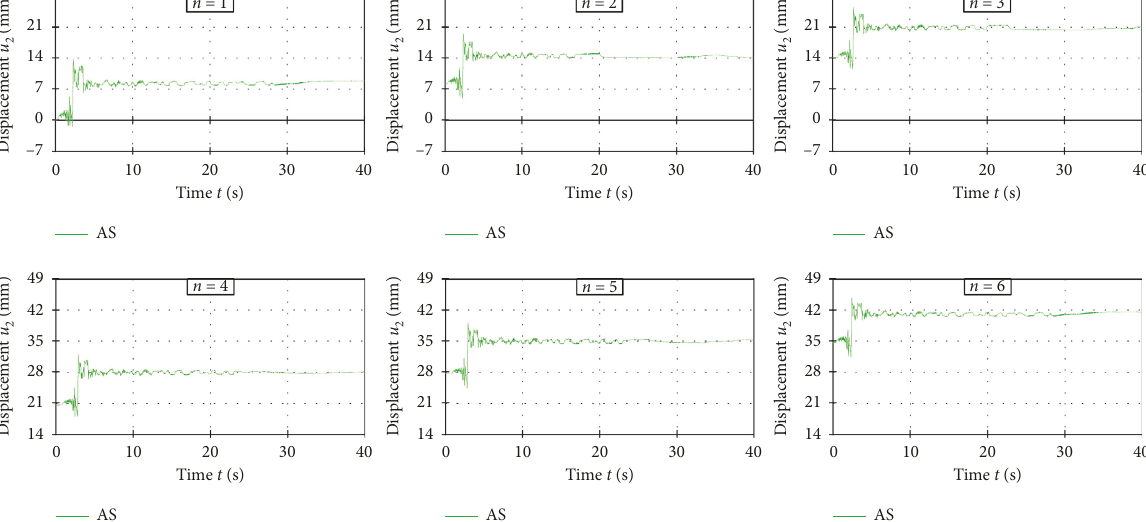
2 for repeated excitation